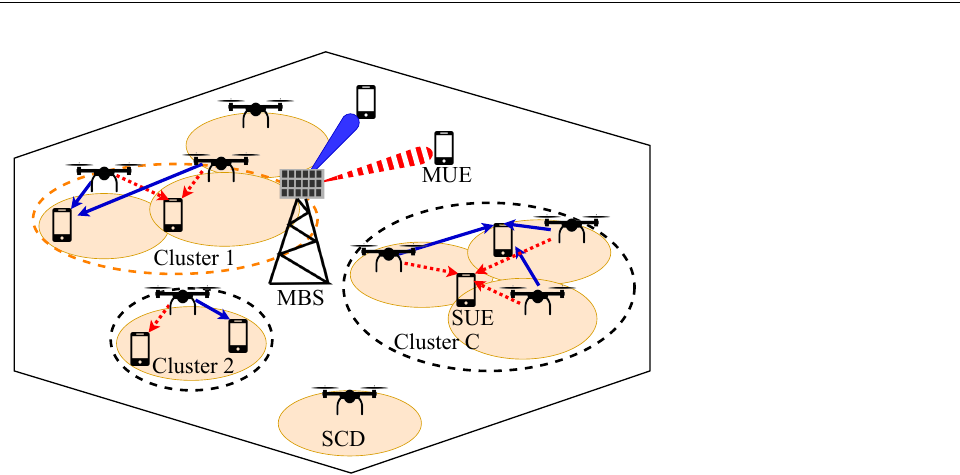
Figure 1. A typical hexagon macrocell in UDNs. Each small cell has an SCD as a flying base station with bounded circle coverage. Dotted red lines and beams denote the signal from BSs to UEs in a subchannel, while the others denote the signal in another